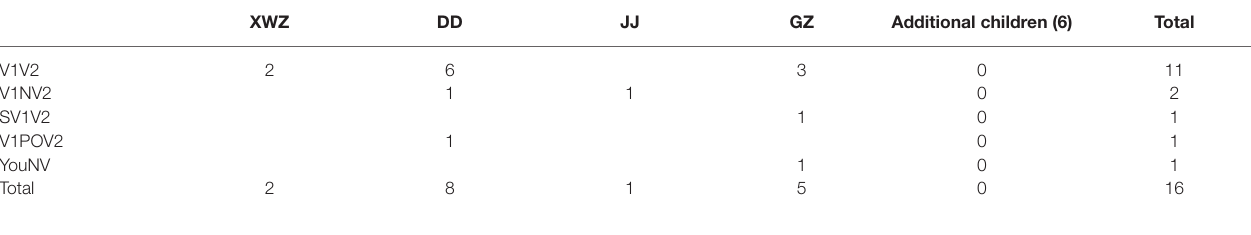
TABLE 6 | Frequency of Multiverb sentences used by 20 m TD children.